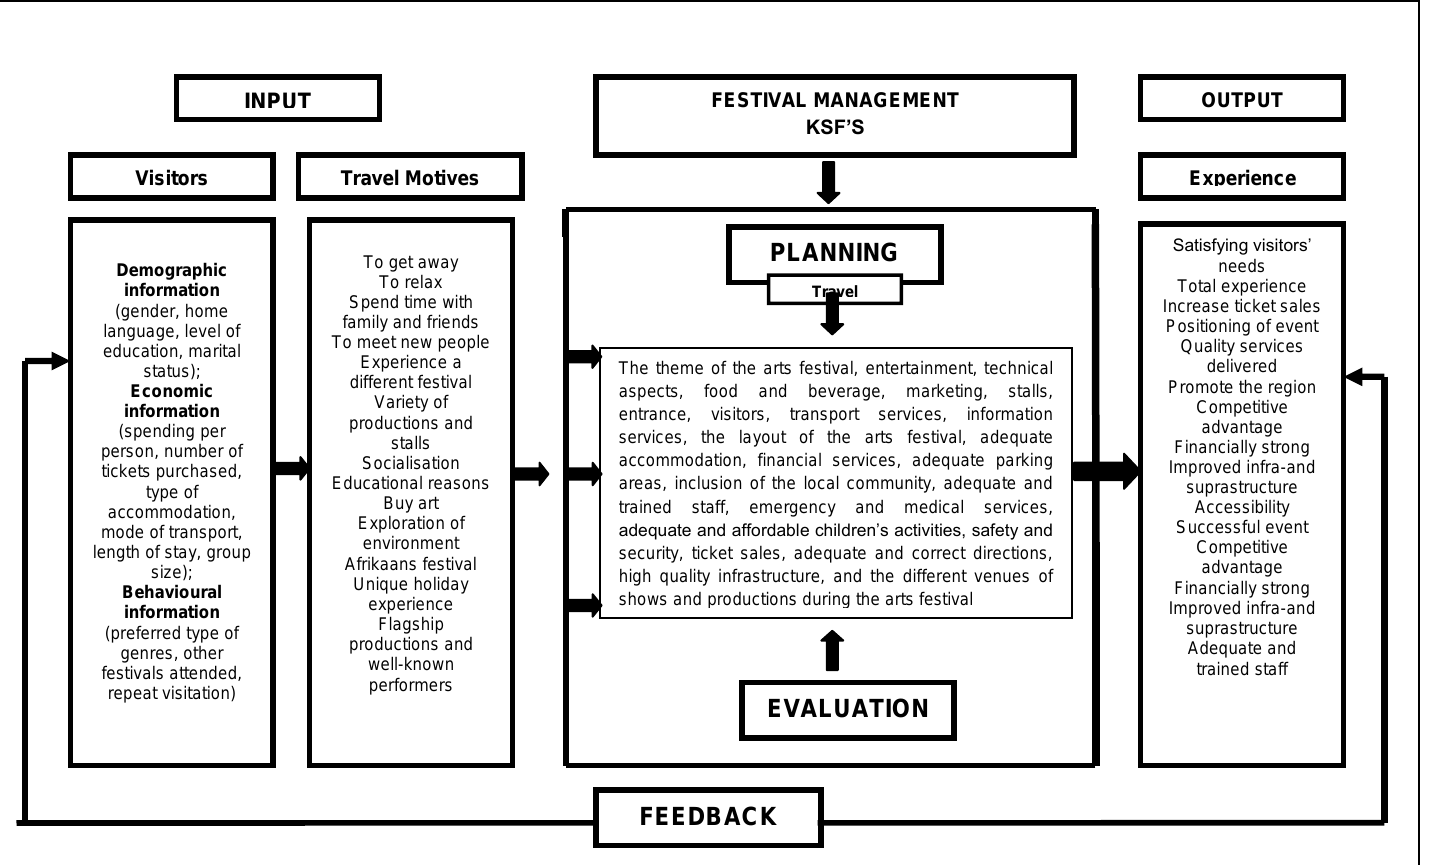
Figure 1: Relationship between planning and